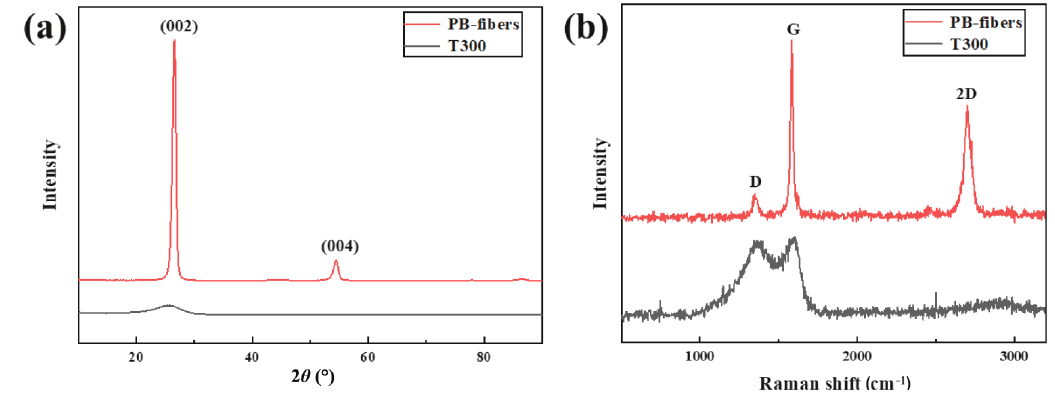
Fig. 2 XRD patterns and Raman spectra of T300 and PB-fibers.